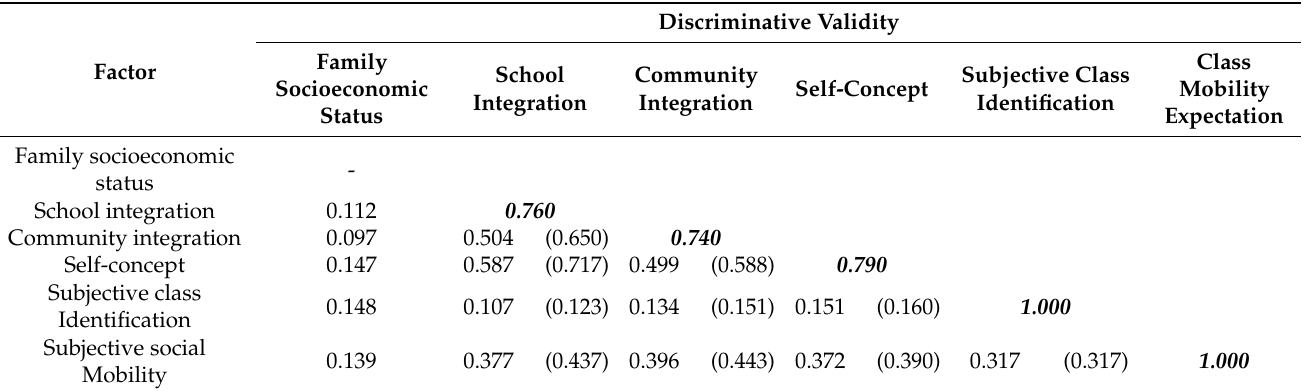
Table 3. Factor characteristics of the measurement model: discriminative